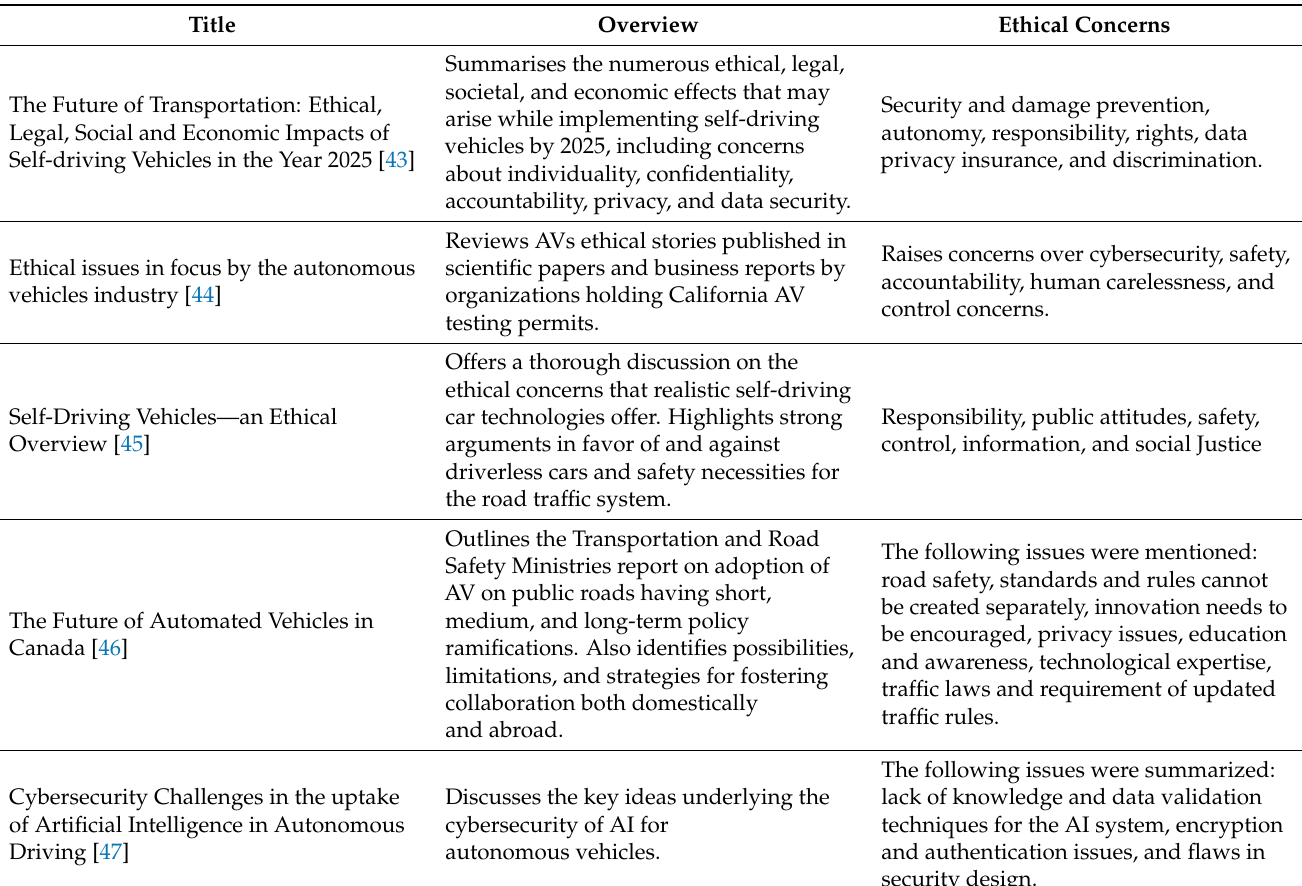
Table 3. Ethical dilemmas in Autonomous